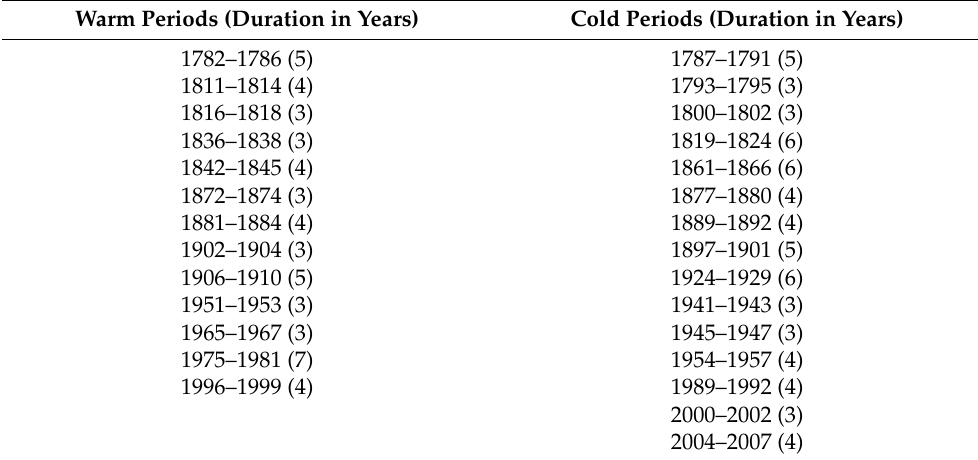
Figure 7. Reconstructed mean June–July temperatures of Srinagar during 1773–2012. The horizontal purple line is the mean June–July temperature of the instrumental data whereas the blue and red horizontal lines indicate 10th and 90th percentiles, respectively. The red and blue solid circles/text indicate the top 10 warm and cool years, respectively. Table 3. Warm and cold periods from the reconstruction of mean June–July temperature of Srinagar, Jammu, and Kashmir, India during